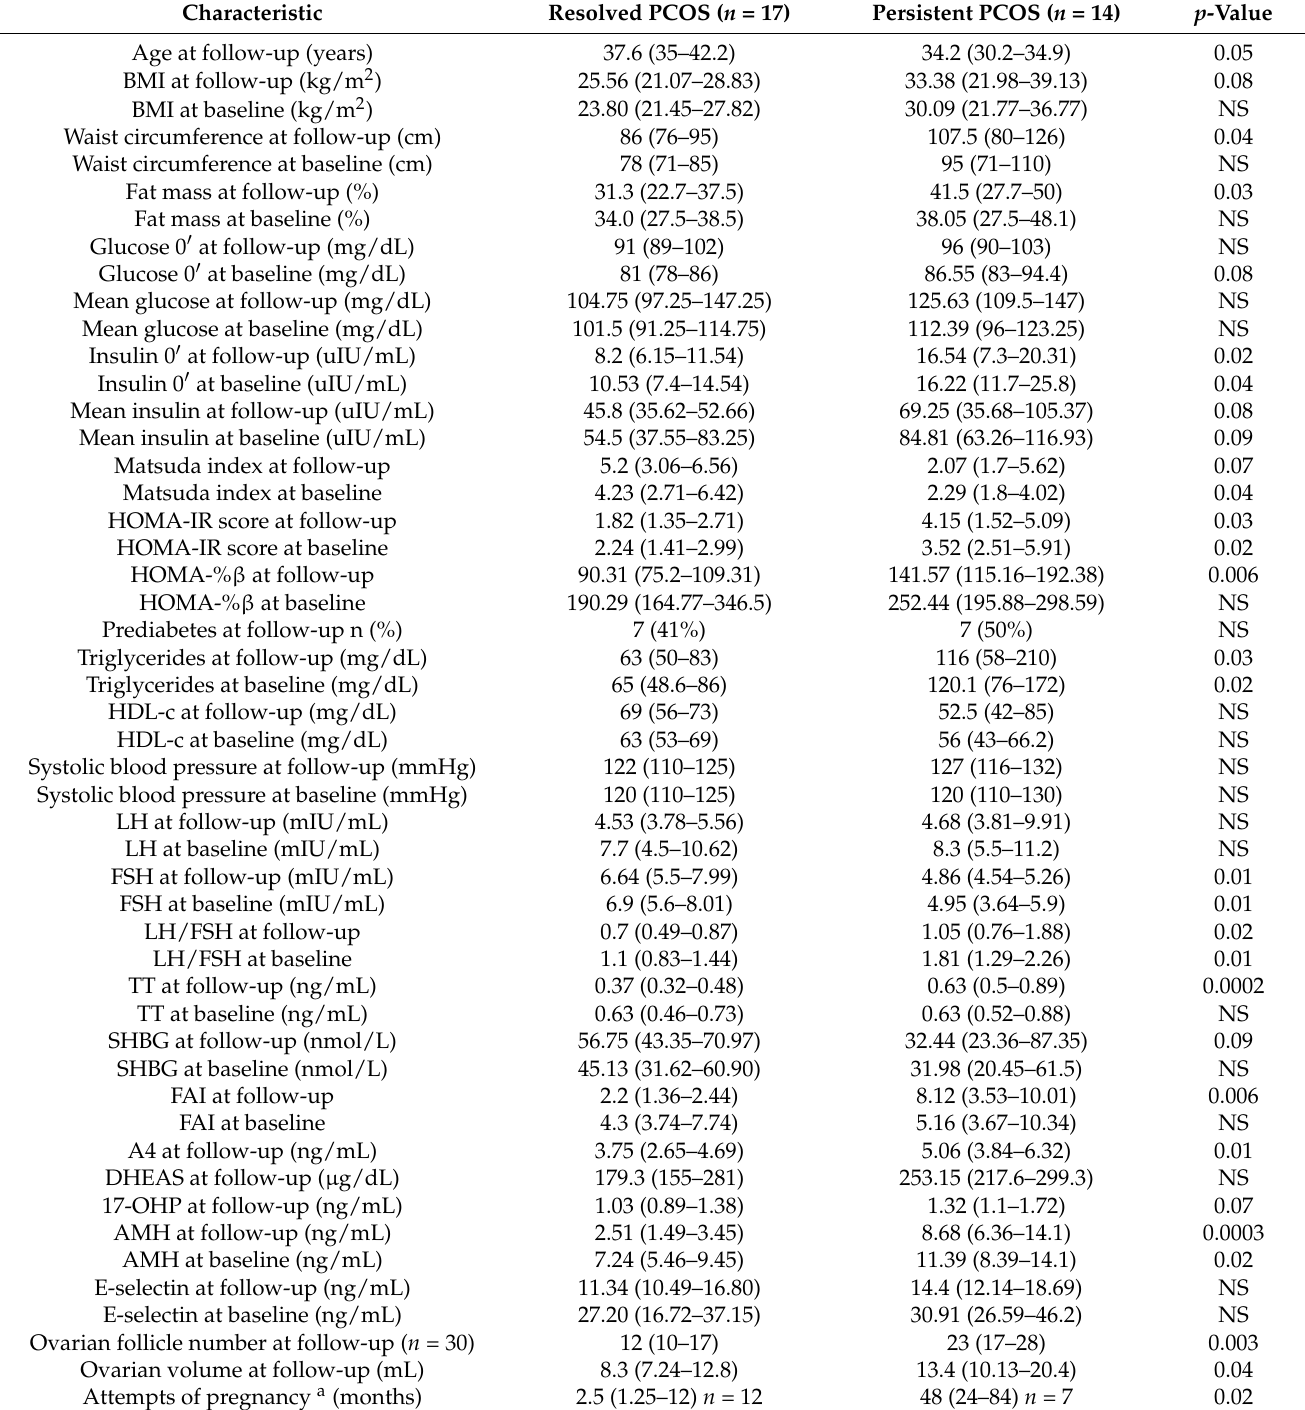
Table 5. Characteristics of the women according to PCOS * status assessed at the end of the follow-up.